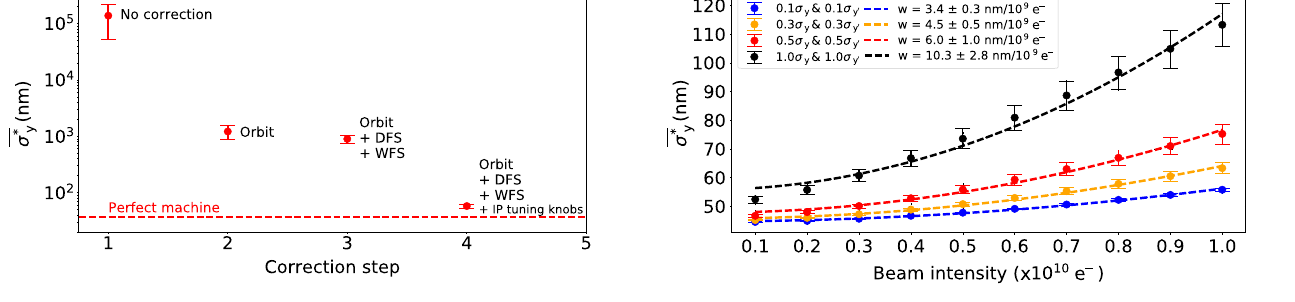
FIG. 8. Average vertical beam size at the IP ( σ (cid:1) y ) vs correction step: Orbit, DFS, WFS corrections and IP tuning knobs. The error bars represent the standard error of 100 machines. The red dashed line shows the 37 nm IP vertical beam size for a perfect machine.